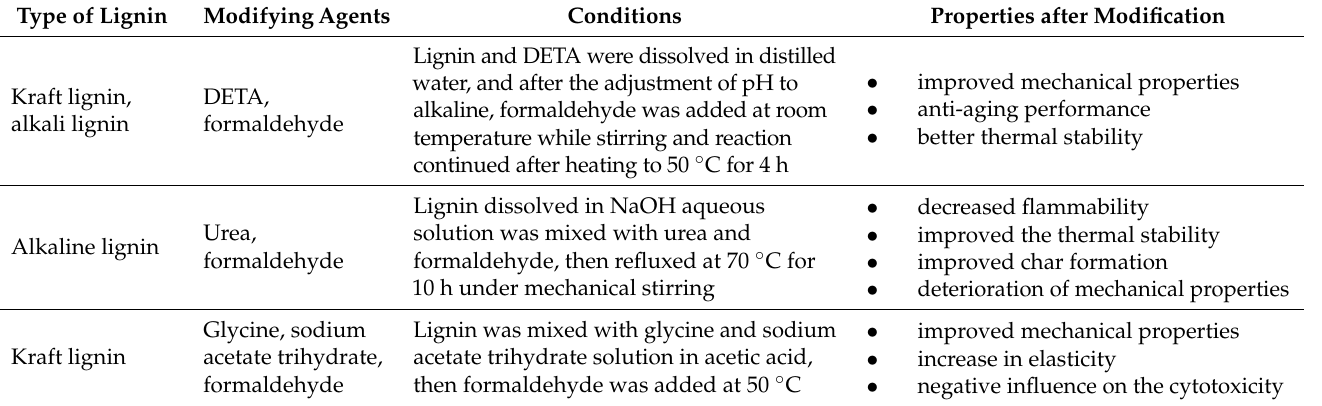
Table 10. Table summarizing the amination reaction of